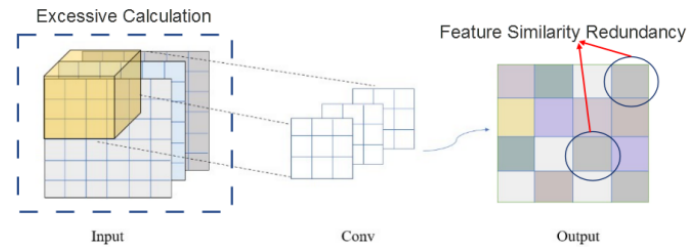
Figure 6. The general